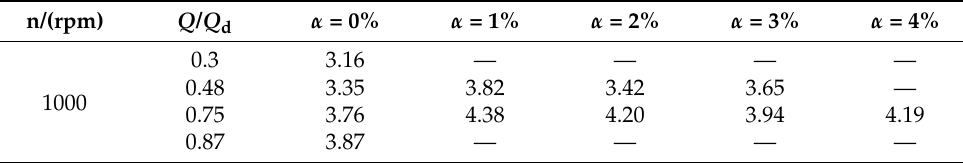
Table 2. Average relative uncertainties Ur for different inlet void